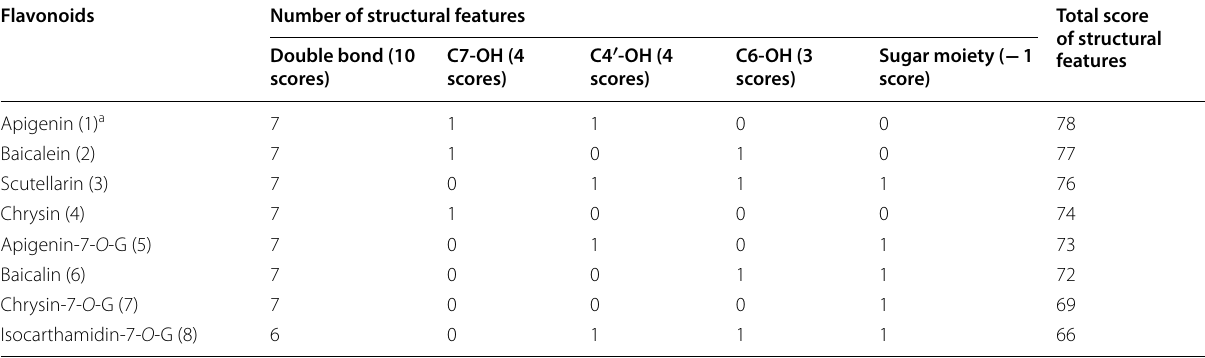
G glucuronide a Eight flavonoids are arranged in a decreasing order of inhibitory effects against both α-glucosidase and α-amylase